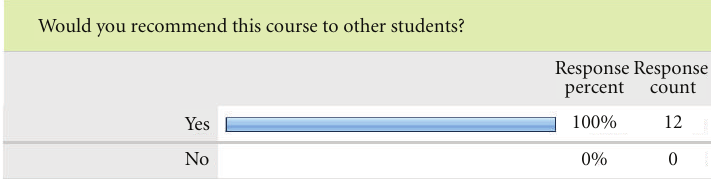
Figure 3: Survey Excerpt: Students’ response on whether or not recommending the course to